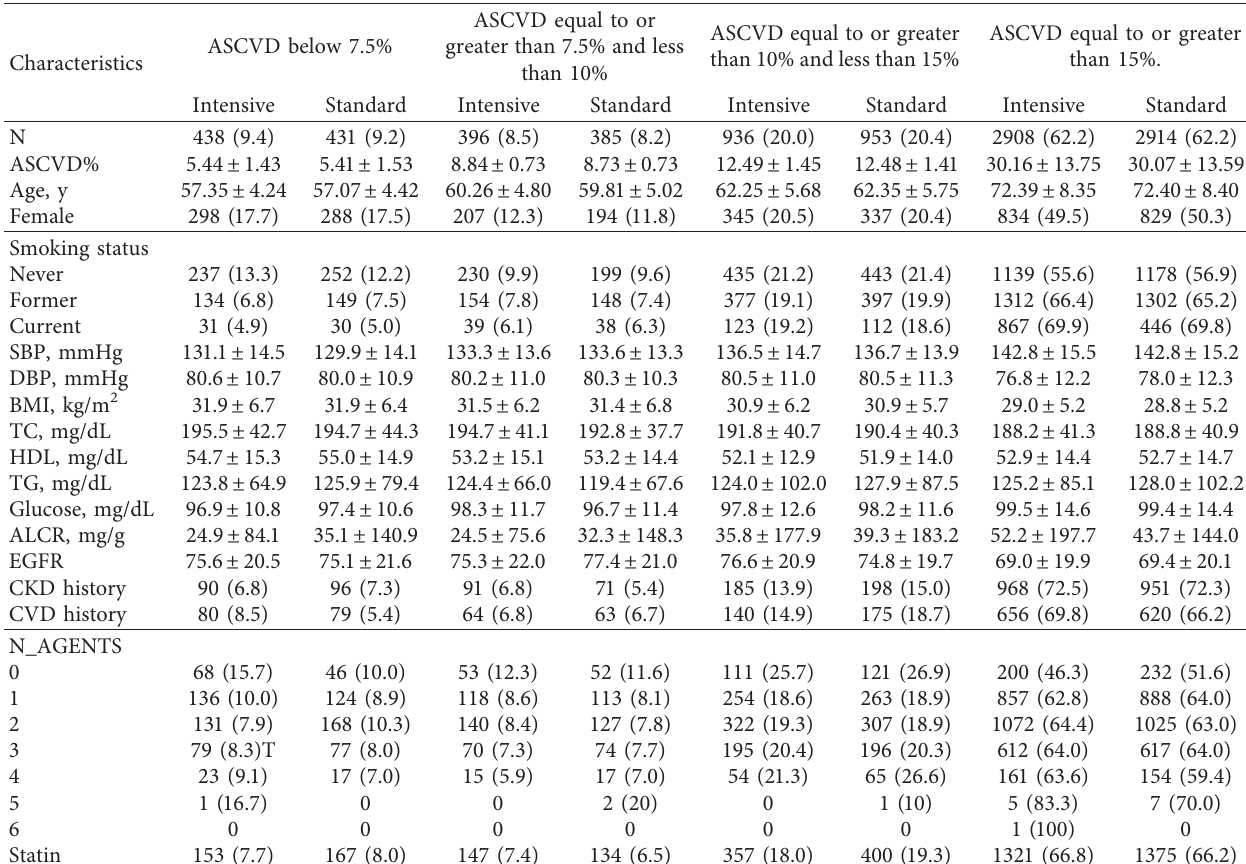
Table 1: Demographic and clinical characteristics of participants with different baseline ASCVD risk